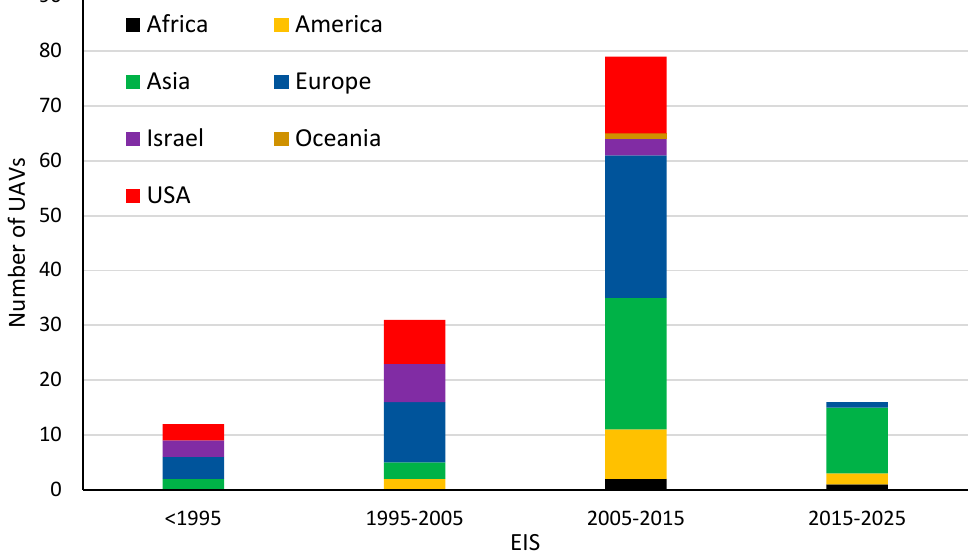
Figure 29. Number of UAVs introduced per region per EIS.